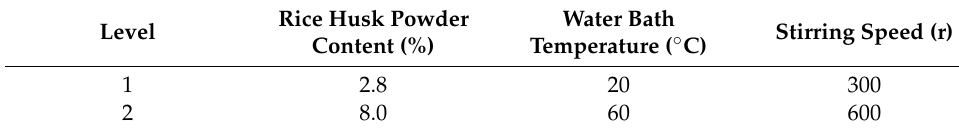
Table 2. Influencing factors and levels.